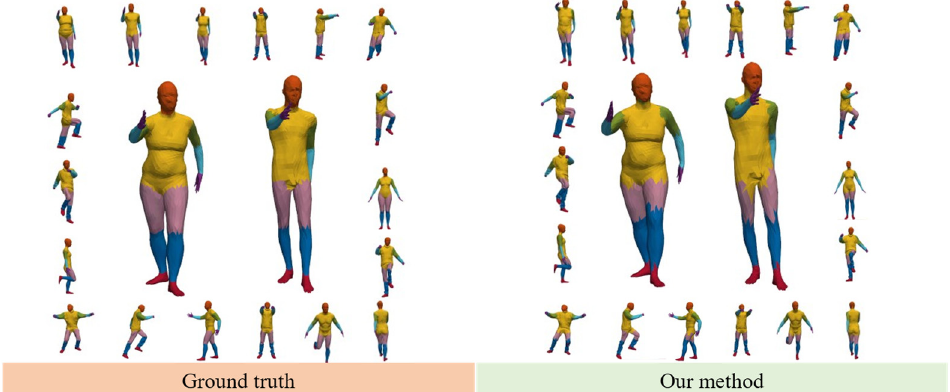
Figure 5. 3D human model torso structure semantic segmentation effect visualization (each part of the human body is marked with the following colors. Head: orange, torso: yellow, arms: green, forearms: light blue, hands: purple, thighs: root color, calves: dark blue, and feet: red).